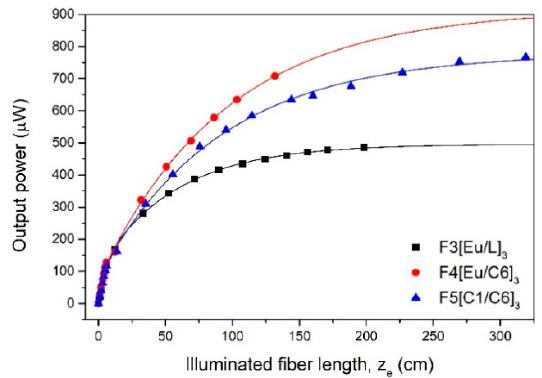
Figure 9. Evolution of the output power as a function of the illuminated fiber length for 1 mm diameter samples. Symbols: experimental points; solid lines: fitted curves.